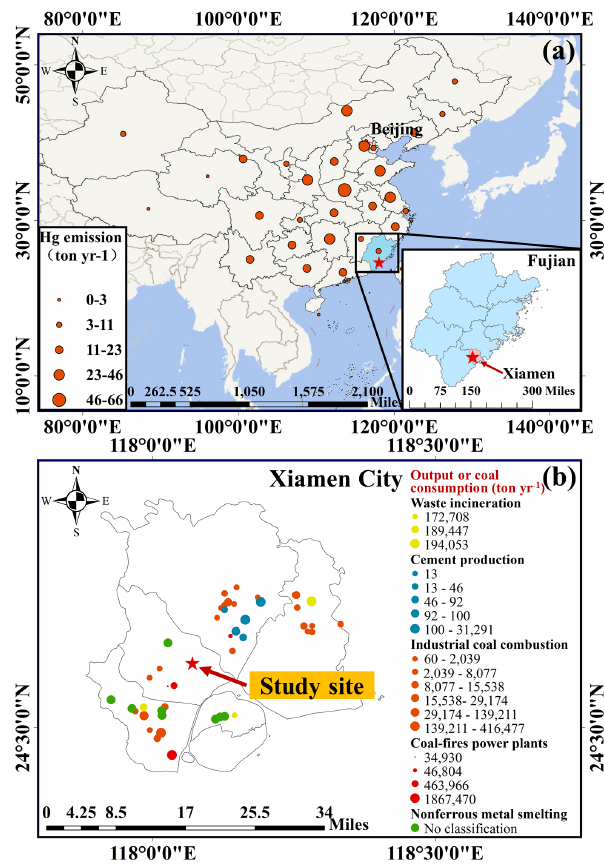
Figure 1. (a) The location of study site in Xiamen, Fujian Province, China, and the regional distribution map of anthropogenic Hg emis- sions in China in 2014 (Wu et al., 2016). Note that the red dots represent the amount of mercury emitted by each province. (b) The distribution of local industrial point sources in Xiamen. Note that the colors of the dots represent different industrial categories, and the size represents a company’s output or coal consumption (tyr − 1